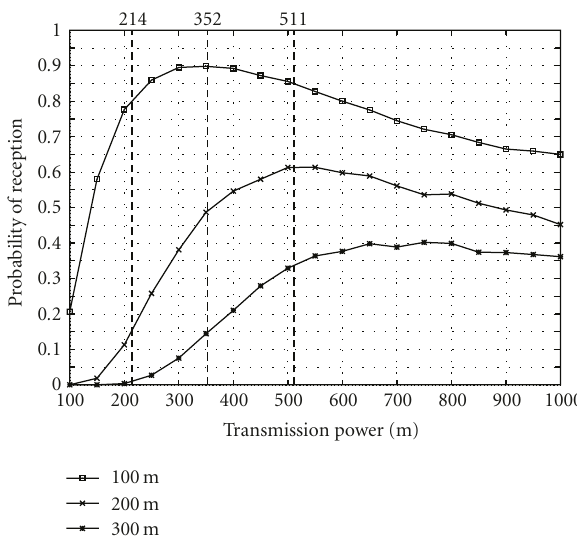
Figure 8: Scenario A (cf. Table 4). Probability of packet reception w.r.t. chosen power value: analytical computation (numbers) and simulative results